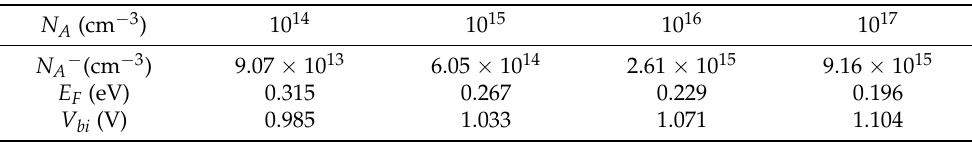
Table 1. Fermi level E F , ionized dopants N A − , and V bi in CdTe with different doping densities from 10 14 to 10 17 cm − 3